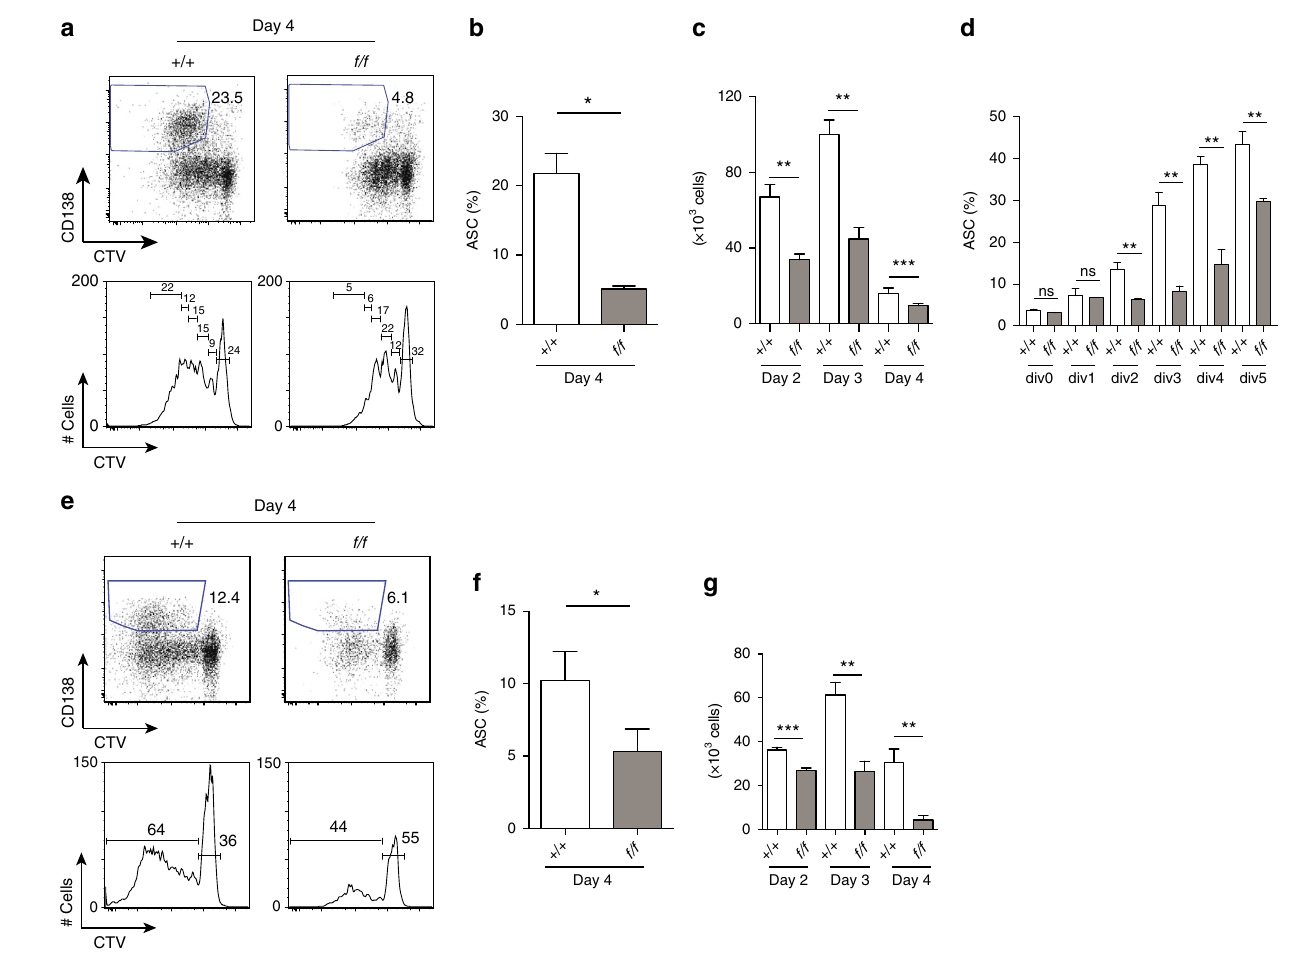
Fig. 3 Defective response of Prmt1 -de fi cient B cells to in vitro stimulation. Control ( + / + ) and Prmt1 f/f CD23Cre ( f/f ) splenic B cells, labelled with CTV, were activated with a – d CD40L + IL-4 + IL-5 or e – g LPS (25 μ g ml − 1 ) for the indicated times. a , e Cultured cells were monitored for ASC differentiation with anti- CD138 antibody (top panels) and extent of cell division with CTV dilution (bottom panels). Percentages are the proportion of viable cells within indicated regions. b , f Frequency of live, CD138 + ASC at 4 days after activation. c , g Number of viable cells in cultures after stimulation for the indicated times. d Frequency of CD138 + cells within the indicated cell divisions of CD40L + IL-4 + IL-5 stimulated control ( + / + ) and Prmt1 f/f CD23Cre ( f/f ) splenic B cells at day 4. * P ≤ 0.05 ** P ≤ 0.01, *** P ≤ 0.001 (unpaired t -test). One representative experiment of three, with three biological replicates, is shown. (Mean and